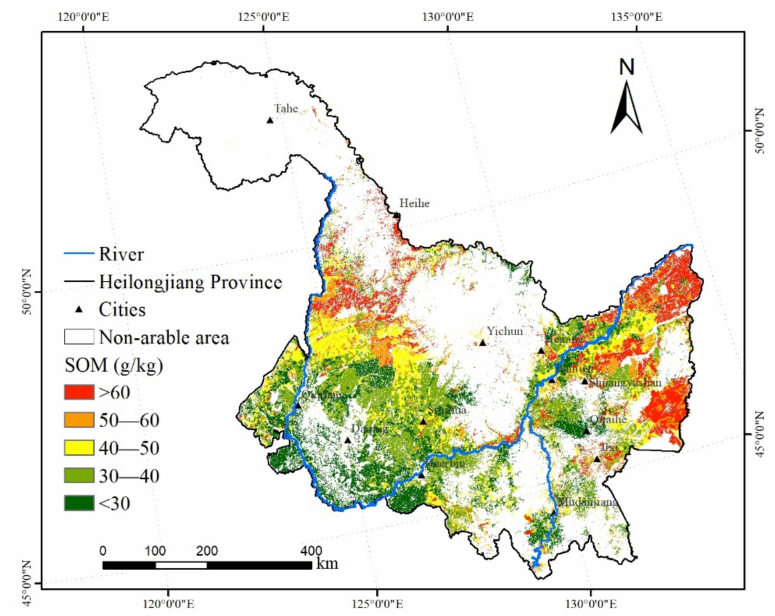
Figure 1. Location of the study area and distribution of observational SOM. Heilongjiang Province mainly has a continental monsoon climate. In summer, the precipitation is sufficient, and the temperature is high. In winter, the weather is dry and cold for a long time. The annual temperature ranges from − 4 to 4 ◦ C. Annual precipitation ranges from 500~600 mm and is mainly concentrated in summer. Mountain areas account for 59% of the province and are concentrated mostly in the northwest, north, and southeast. The Greater Khingan and Lesser Khingan are the two most important mountains in the province. The province has large tracts of land with relatively flat terrain and low elevation, and 80% of the arable land consists of four soil types, Haplic Phaeozem, Haplic Cher- nozem, Luvic Phaeozem, and Albic Luvisol. The solar resources are relatively abundant, approximately 2300~2800 sunshine hours per